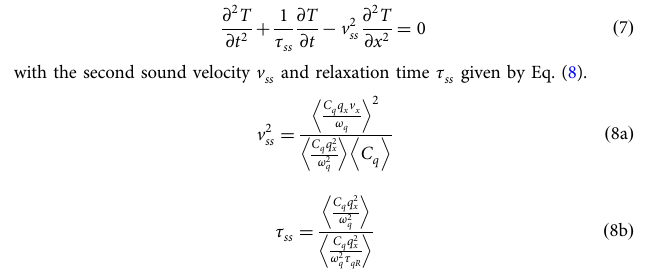
nized with the optical chopper. The pump and probe pulse energies are set at 70nJ and 52 nJ, respectively. The surface temperature rise due to the pulses is estimated to be <3 K.